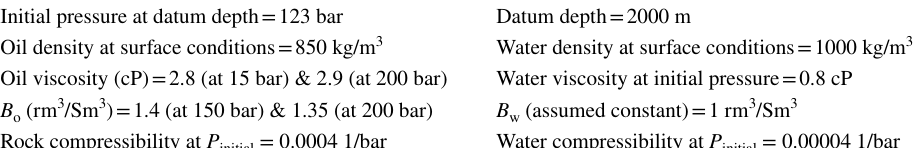
Table 2 PVT data and initial condition of the reservoir